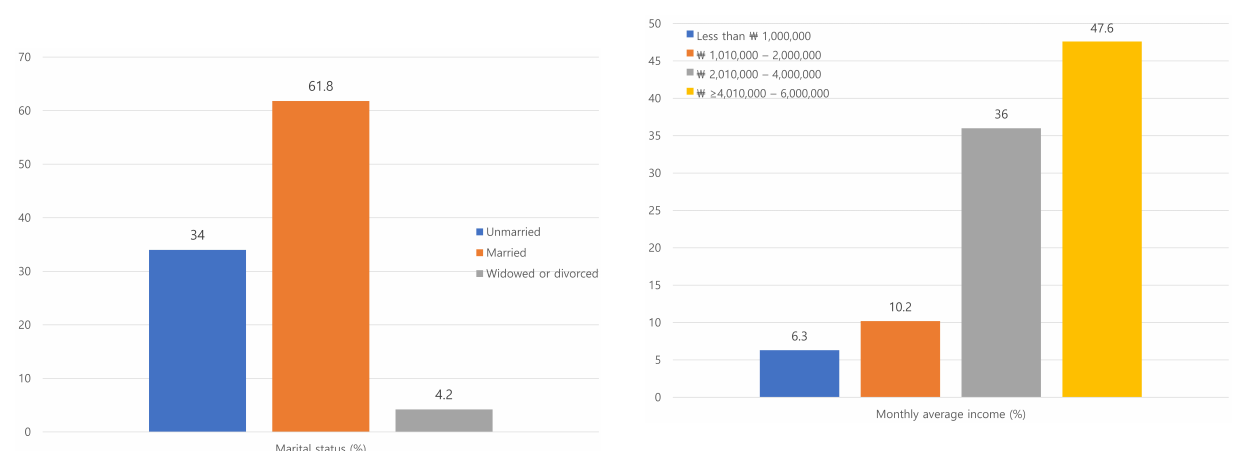
Fig. 1. Age of study participants. (%)